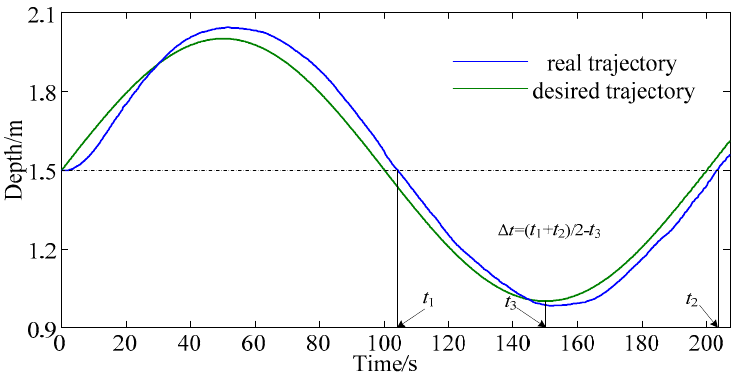
Figure 4. Experimental result curve on depth control with no improvement.